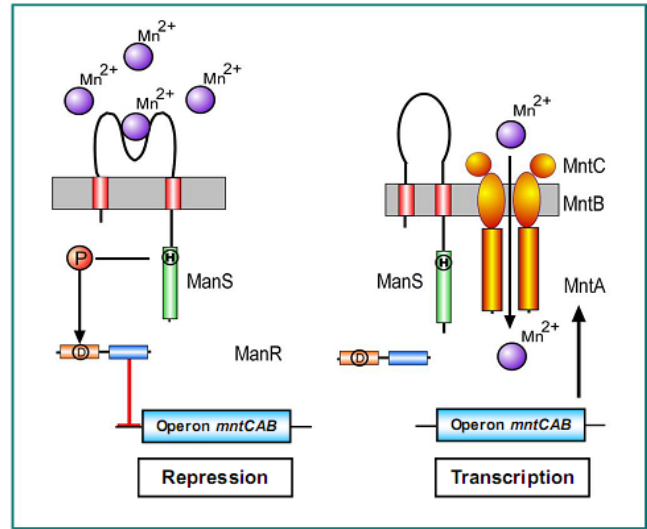
Figure 6 . Hypothetical model for the sensing of Mn 2+ ions, the transduction of the Mn 2+ signal, and the regulation of expression of the mntCAB eperon that encodes the Mn 2+ transporter. His and Asp residues that might be involved in a phosphorelay are indicated by the encircled H and D, respectively. Adopted from